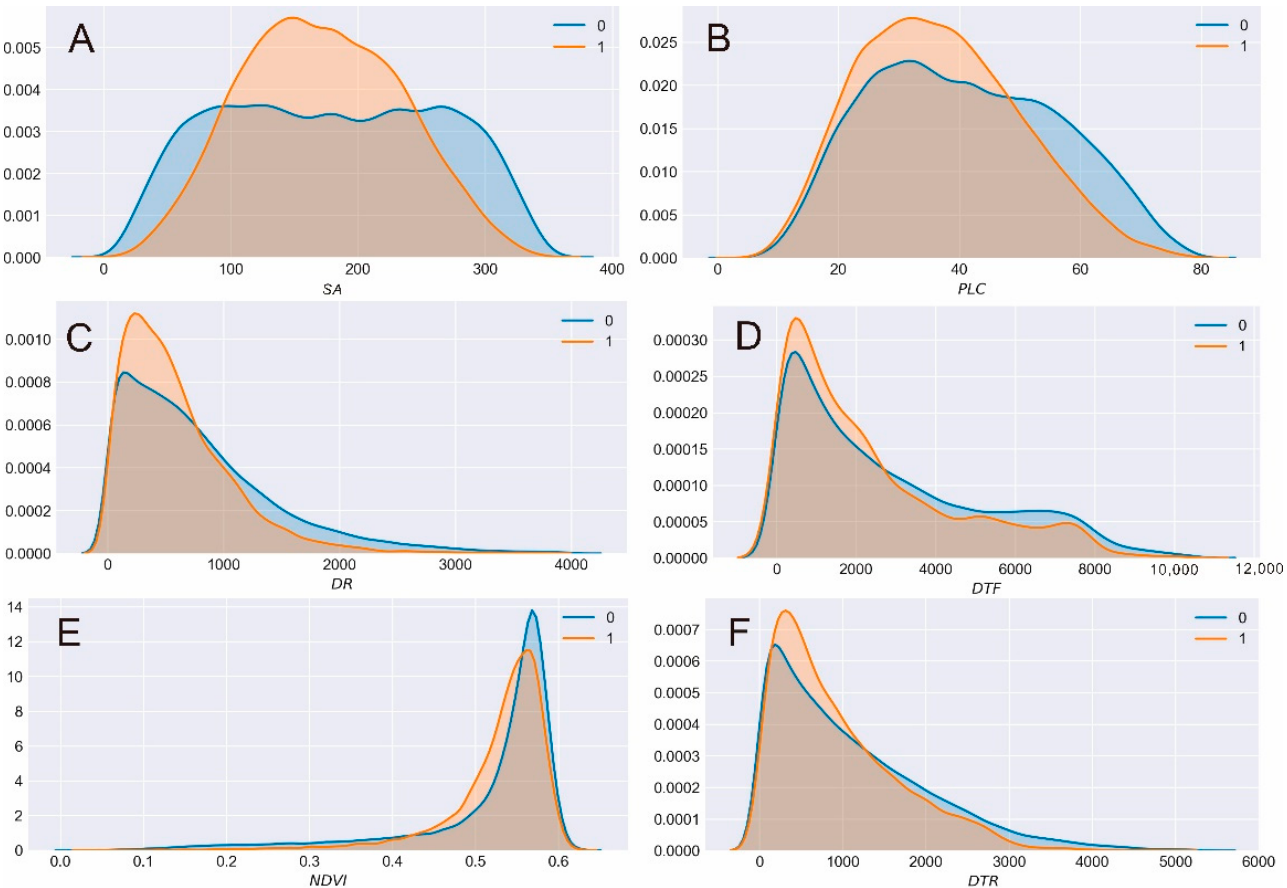
Figure 13. Distribution of ( A ) Slope aspect (SA), ( B ) Planar curvature (PLC), ( C ) Distance to river (DR), ( D ) Distance to fault (DTF), ( E ) Normalized Difference Vegetation Index (NDVI), and ( F ) Distance to road (DTR). ‘1 (0)’ indicates grid cells prone to (not prone to) landslides.